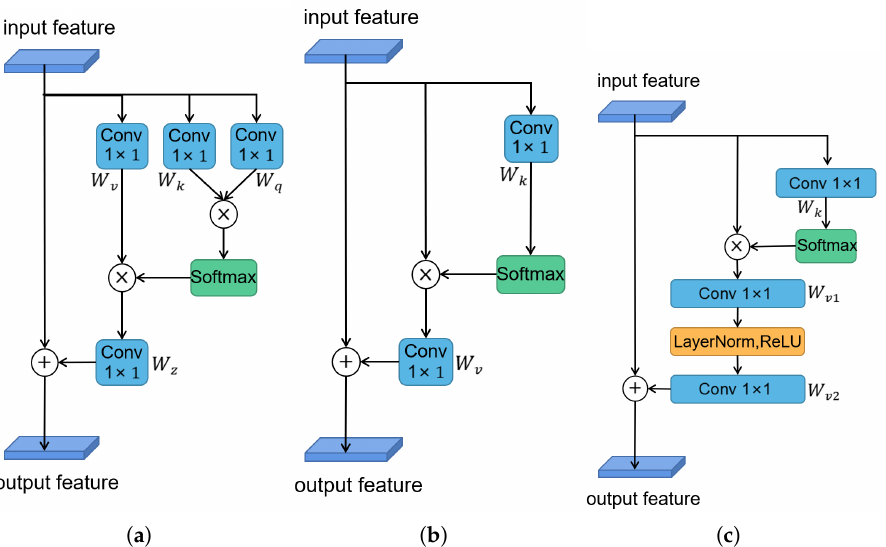
Figure 4. The structure of non-local self-attention. ( a ) The architecture of original non-local attention version (embedded Gaussian), ( b ) its simplified version, and ( c ) the final version that we used. ⊗ denotes matrix multiplication, ⊕ denotes broadcast elementwise